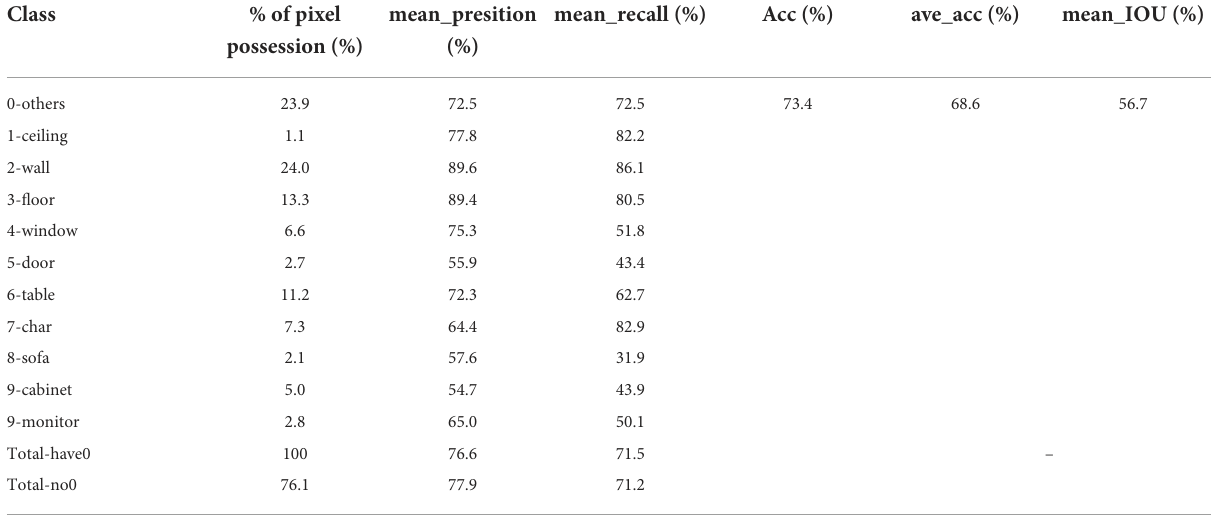
TABLE 2 Statistics of the final evaluation index